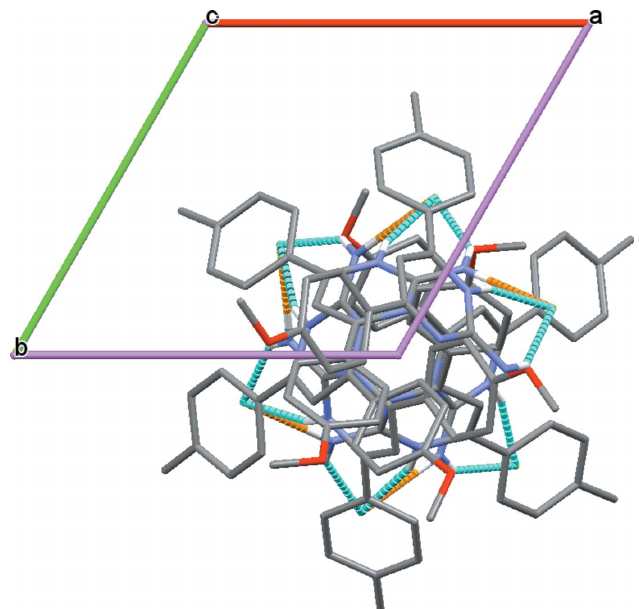
Figure 3 Part of the crystal structure shown along the c axis. The three N—H (cid:2)(cid:2)(cid:2) Cl hydrogen bonds connect molecules in a helical manner along the c axis.